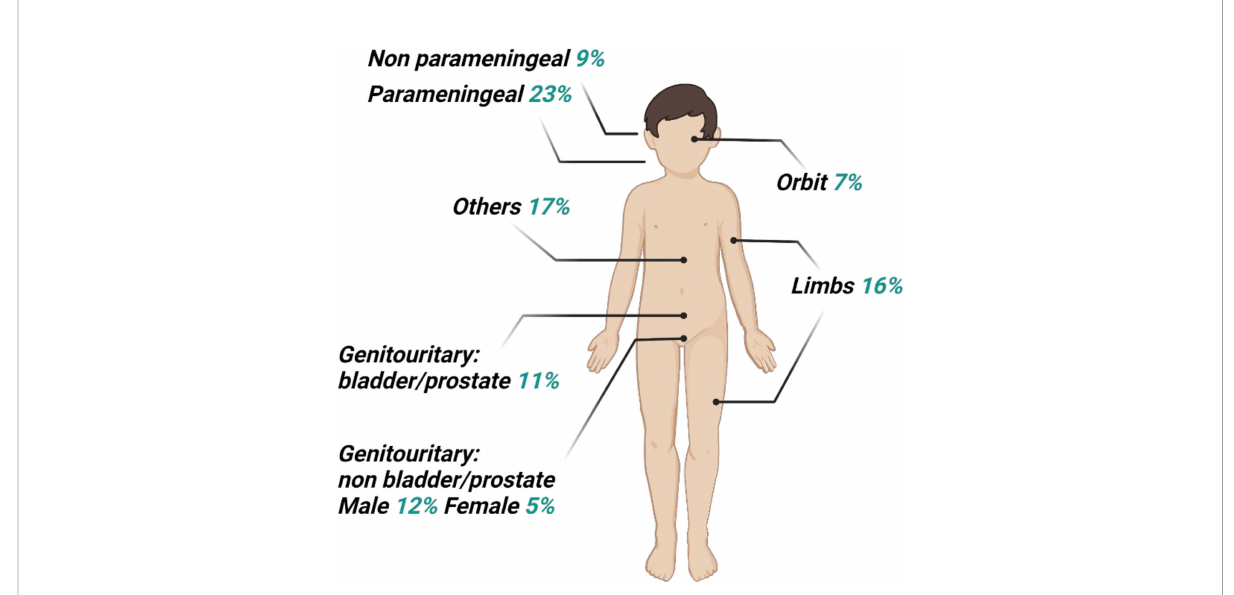
FIGURE 1 Distribution of primary sites for rhabdomyosarcoma. The head and neck site may be subdivided as 7% orbit, 8% other head, 23% parameningeal, and 9% non-parameningeal. The pelvic sites may be subdivided as 11% bladder and prostate, and 5% female genital or 12% male